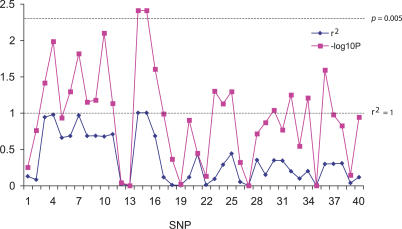
RA-Associated SNPs are Highly Linked to SNP14Pairwise LD (r
2) between associated SNP14/rs10818488 and all other SNPs genotyped was calculated. For each of the SNPs listed along the x-axis we show the –log10 (y-axis) of the p-values for RA patients versus controls. Dotted lines indicate a nominal p-value of 0.005 and a maximal r
2 value of 1. In a logistics regression model, only SNP14/rs10818488 remained statistically significant (p = 6.16 × 10−4)